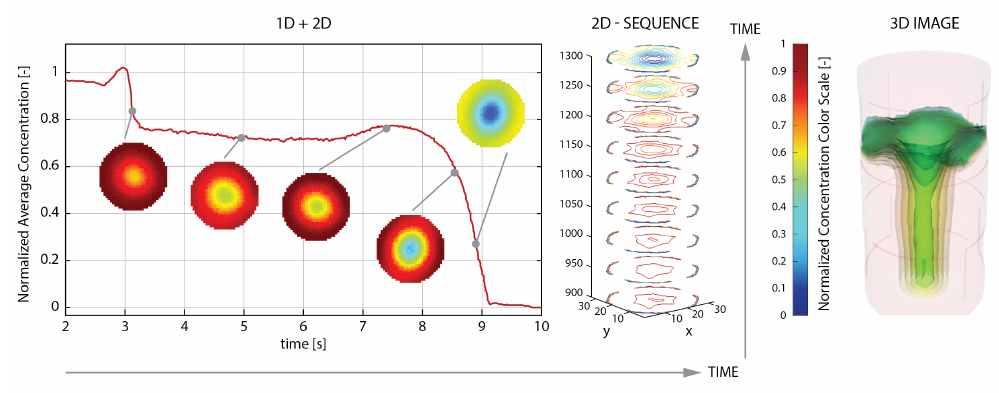
Figure 1. ECT data visualizations. ( Left ) 1D average concentration time plot combined with 2D reconstructed images for selected measurement frames showing the development of funnel flow over time; ( Middle ) sequence of 2D images formed in a vertical time stack; ( Right ) a single 3D reconstructed image of the silo flow with a flowing funnel feature visible.